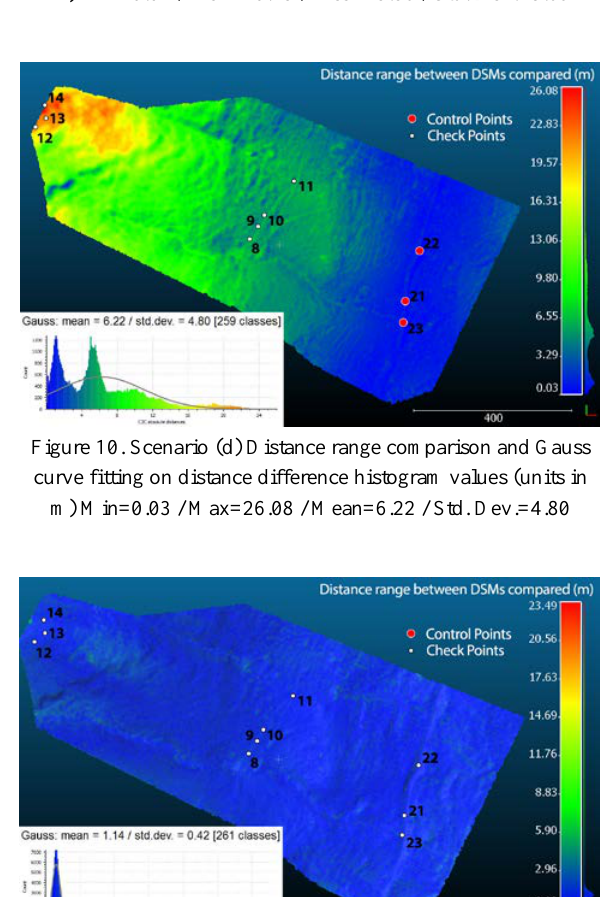
Figure 9. Scenario (c) Distance range comparison and Gauss curve fitting on distance difference histogram values (units in m) Min=0.01 / Max=20.43 / Mean=5.56 / Std. Dev.=3.69